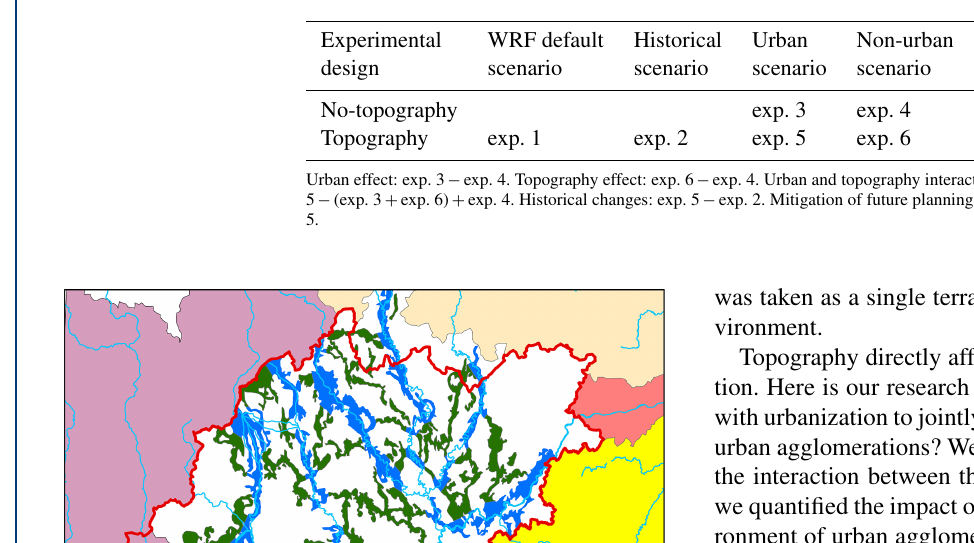
Table 2. WRF experimental design; exp.: experiment.